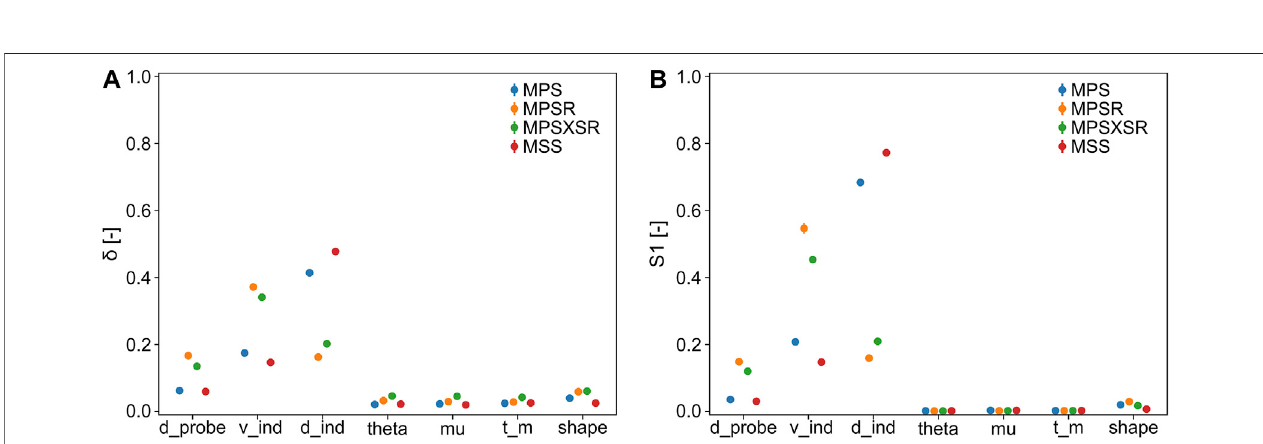
FIGURE5| Sensitivity indicators (with95%con fi denceinterval)oftheinjurymetrics withrespecttotheinputparameters (d_probe (cid:1) diameteroftheprobe, v_ind (cid:1) velocityof indentation, d_ind (cid:1) depth ofindentation, theta (cid:1) inclination of theprobe, mu (cid:1) DAM-probe friction, t_m (cid:1) thickness DAM, and shape (cid:1) shape ofthe tip ofthe probe). (A) δ moment-independent measure; (B) S 1 fi rst-order sensitivity